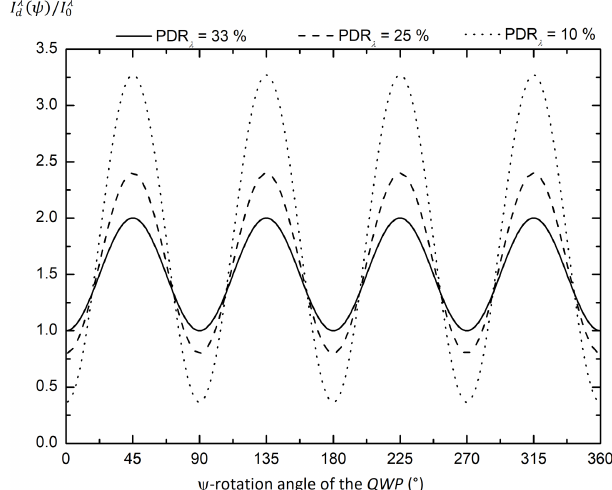
Figure 3. Numerical simulation of the dust backscattered light in- tensity I λ (ψ)/I λ, 0 as a function of the orientation ψ of the QWP at a given wavelength at the following three case studies: PDR λ = 33% (in full lines, corresponding to F 22 ,λ /F 11 ,λ = 0 . 50), PDR λ = 25% (in dashed lines, F 22 ,λ /F 11 ,λ = 0 . 60), PDR λ = 10% (in dot- ted lines, F 22 ,λ /F 11 ,λ = 0 .